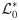
The end product of the Seifert graph of the link L0* given in Fig 3, after all possible special reductions are performed.